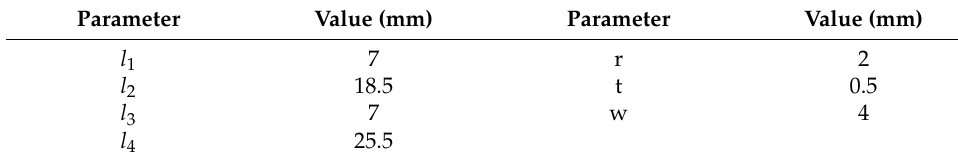
Table 2. Design parameters of straight round flexure hinge.